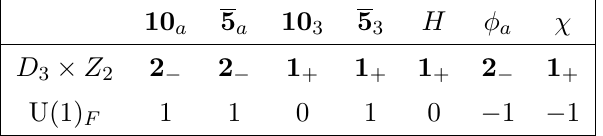
Table 9 . The (cid:12)eld content and ( D 6 ’ D 3 (cid:2) Z 2 ) (cid:2) U(1) F quantum